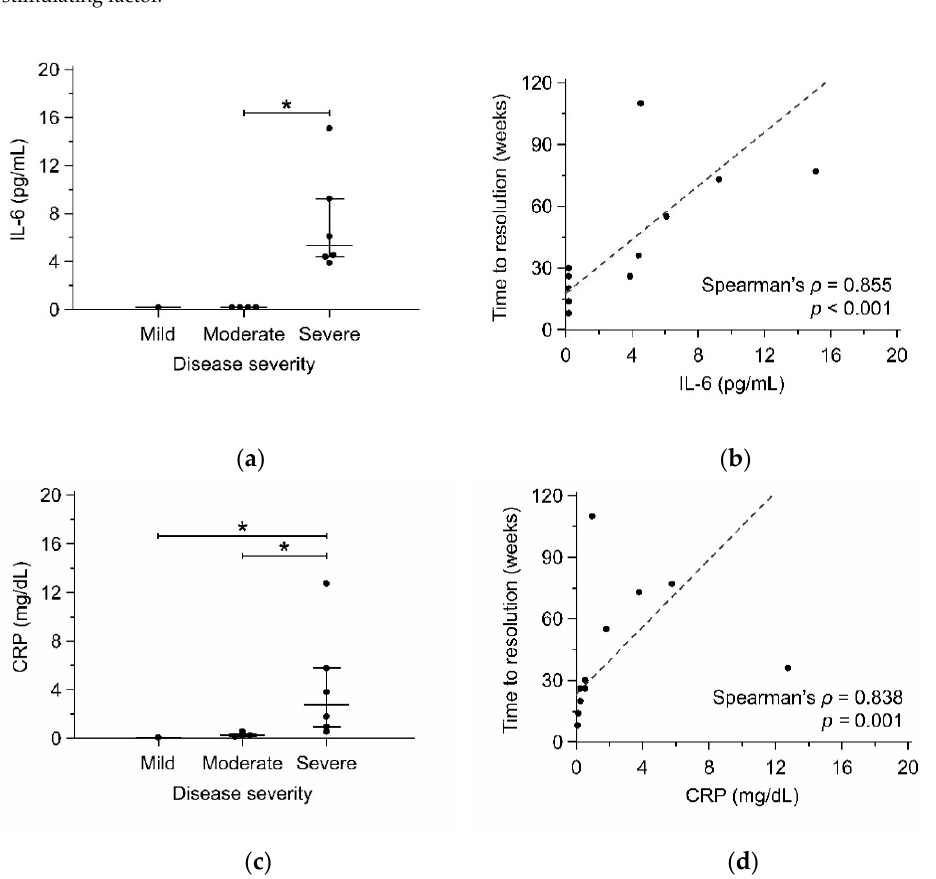
IGM, idiopathic granulomatous mastitis; HC, healthy controls; IQR, interquartile range; TNF, tumor necrosis factor; IL, interleukin; N.D., not detectable; N.A., not applicable; GM-CSF, granulocyte–macrophage colony-stimulating factor.